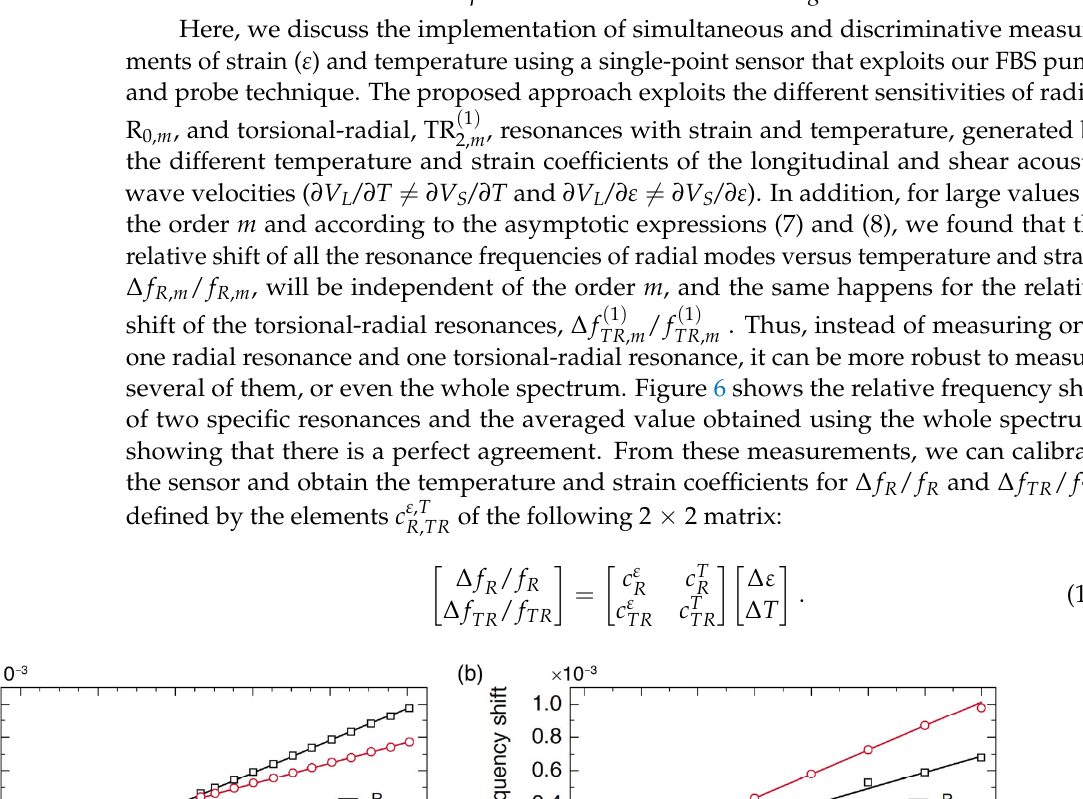
Figure 6. Relative frequency shift of resonances R 0,20 and TR ( b ). Both figures include the averaged values of ∆ f/f over all the resonances, R 0, m and TR each series (solid lines).